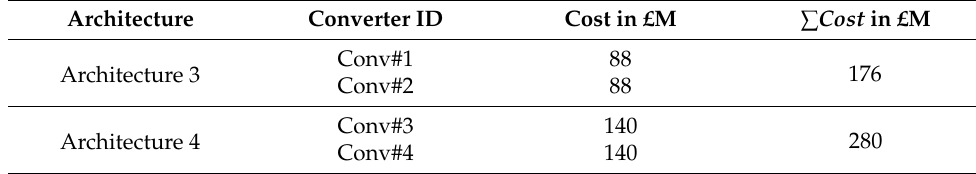
Table 13. HVDC converters’ cost estimation.